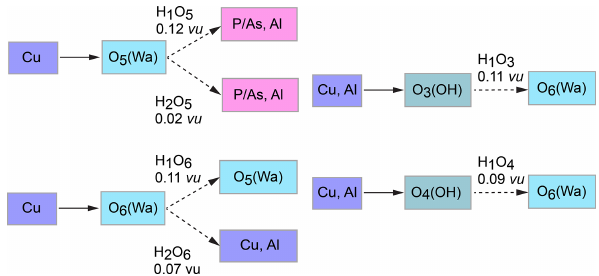
Figure 3. Hydrogen bonding in the structure of liroconite: Cu / Al – octahedrally coordinated cations; Wa – H 2 O molecule; OH – hy- droxyl group; → H bond; bond strengths are given in valence units